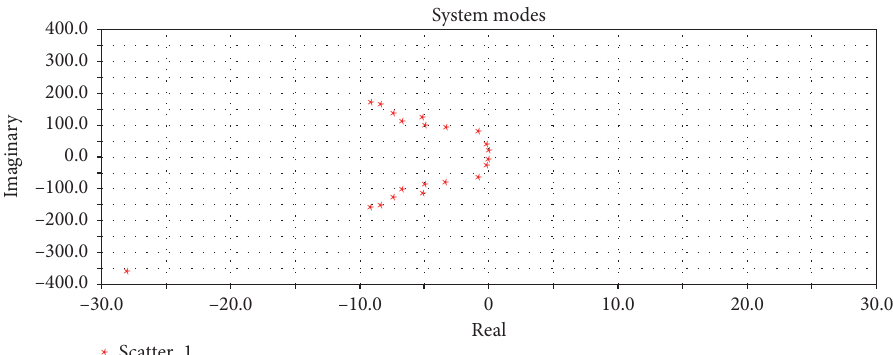
Figure 12: The modal distribution of heavy-duty concrete spreader.